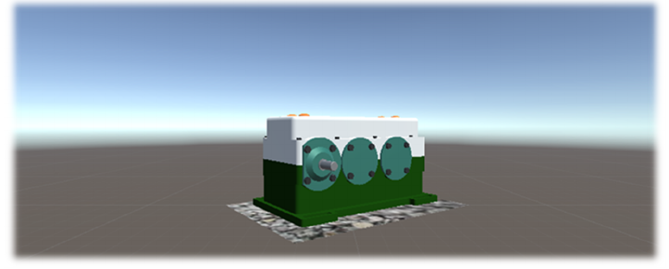
Figure 13. Gearbox in Unity.